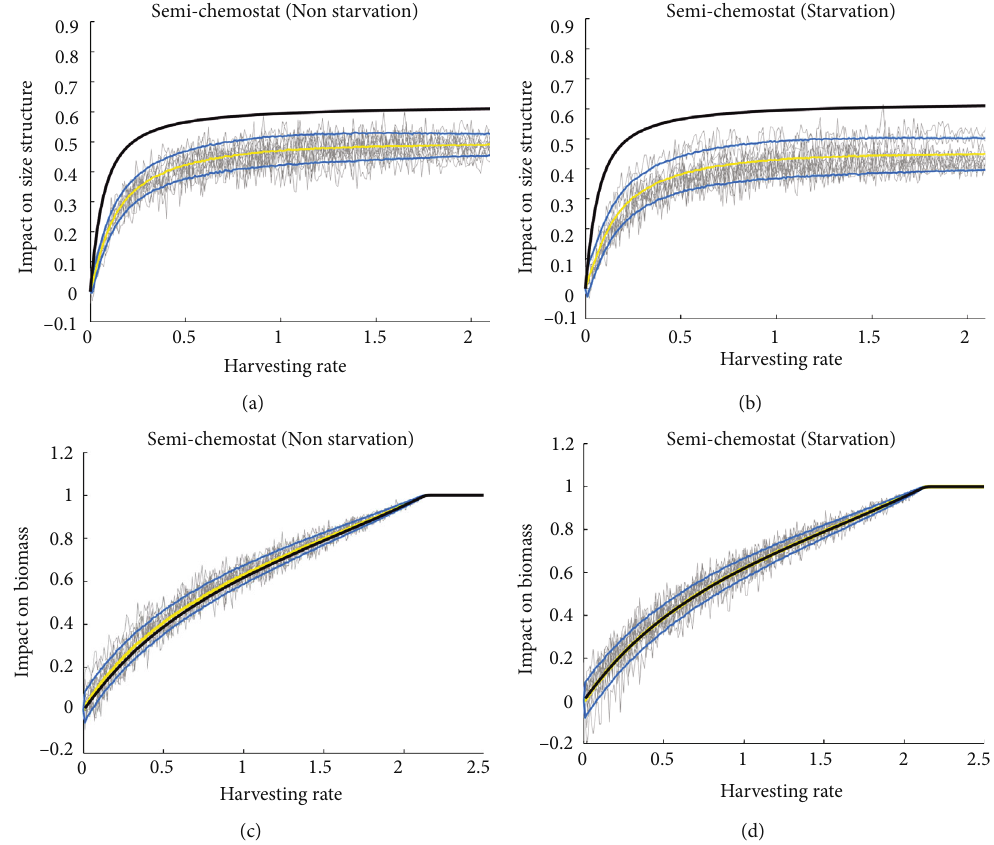
Figure 10: Impact on size structure and biomass of semichemostat growth rate without starvation (a, c) and with starvation (b, d) at steady state w.r.t. harvesting rate. The grey trajectories show the impact on size structure and biomass from di ff erent simulations for the stochastic case. The yellow curve represents the mean value of the simulations. The light blue curves represent the interval of standard deviation (68%). The black curve represents the impact on size structure and biomass for the deterministic case. Equations (17) and (18) are used to derive the above graphs for the impact on size structure and biomass,